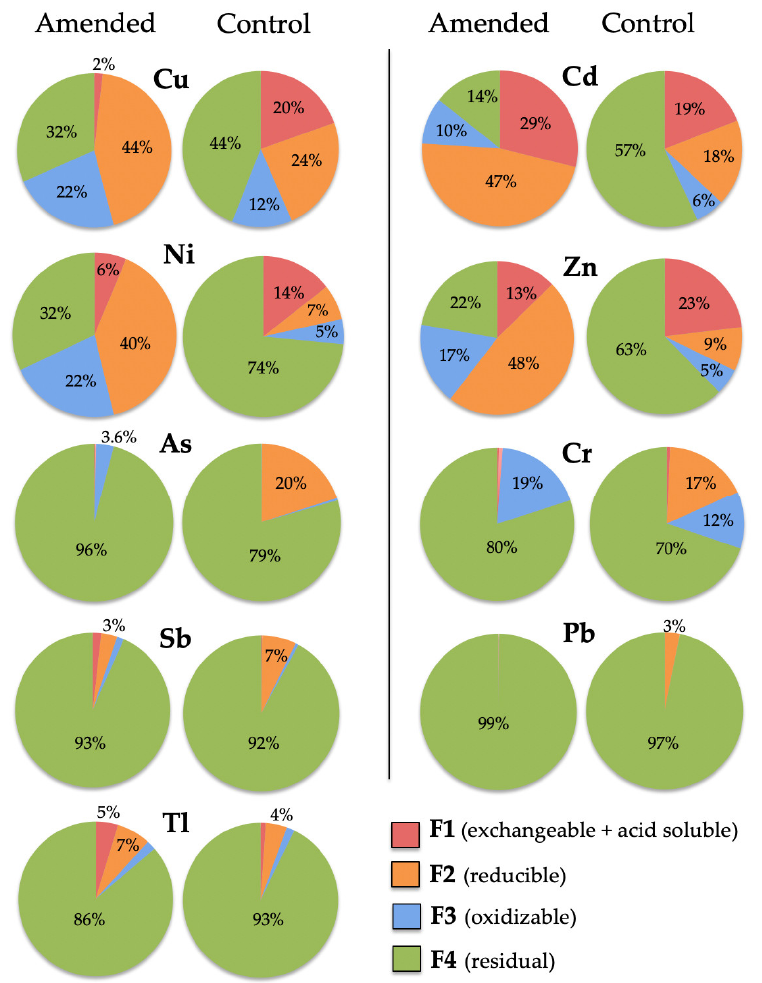
Figure 7. Geochemical partitioning of trace elements in amended soil (sample T10) and control soil (sample ST10). Extraction yields are expressed as percentage of extracted trace elements in operationally defined soil chemical fractions: (F1) water soluble, exchangeable and weak acid soluble; (F2) reducible; (F3) oxidizable; and (F4) residual.